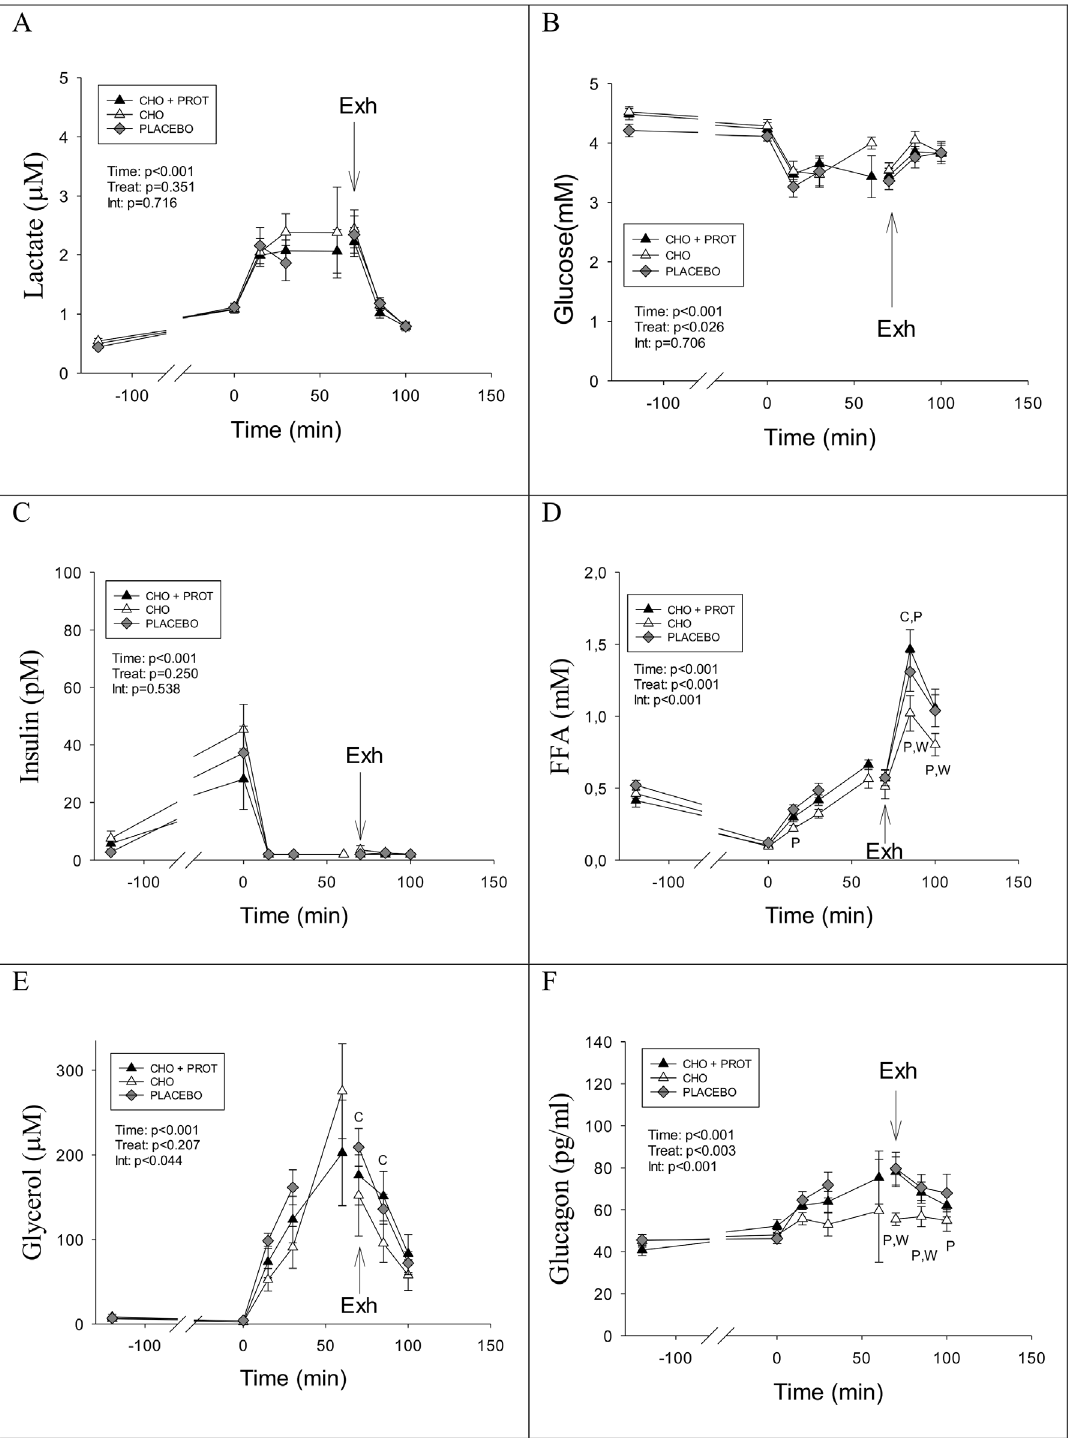
Fig 6. Concentrations of metabolites and hormones in fasted condition the day after exhaustive exercise and diet interventions, and during and after the performance test. Data are mean and error bars represents SEM. C: p < 0.05 compared to CHO; W: p < 0.05 compared to CHO+PROT (whey); P: p < 0.05 compared to placebo. N = 8 for all data